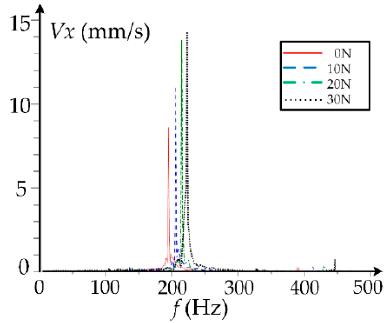
Figure 12. The bearing vibration under different axial loads when L = 1.3.